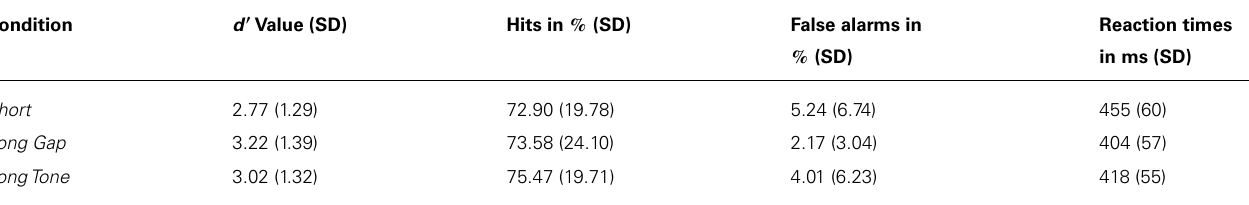
Table 2 | d (cid:3) Values, adjusted hit- and false alarm rate, and reaction times to rule-violating pitch relations obtained in the active deviant detection task for each condition.